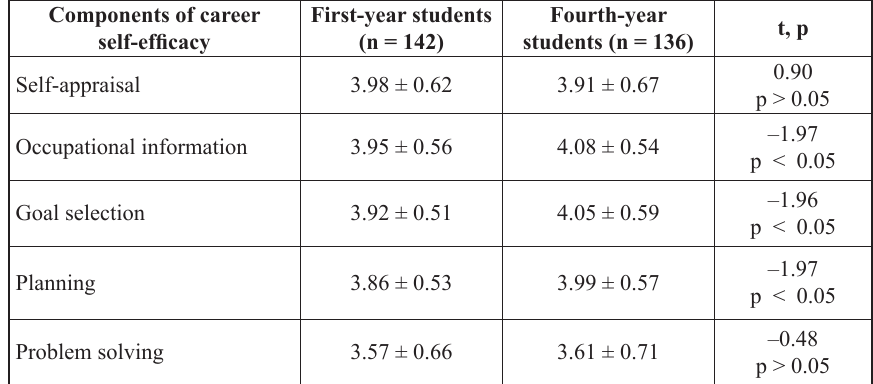
Table 2. Statistical indicators of the components of career self-efficacy of respondents (M ± SD)